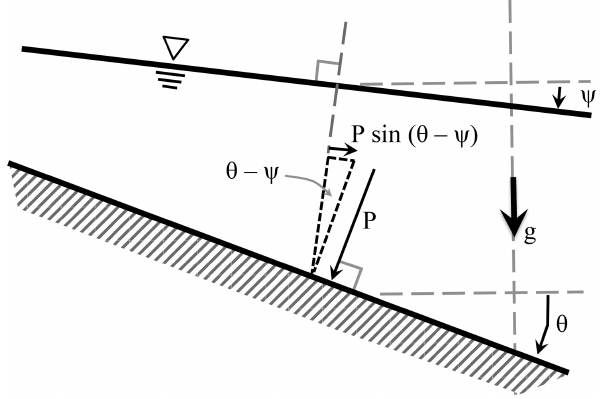
Figure 3. Stair-step approximation for pressure along the bottom where tread is parallel to the free surface and riser is perpendicular for linear slopes of both the bottom and free